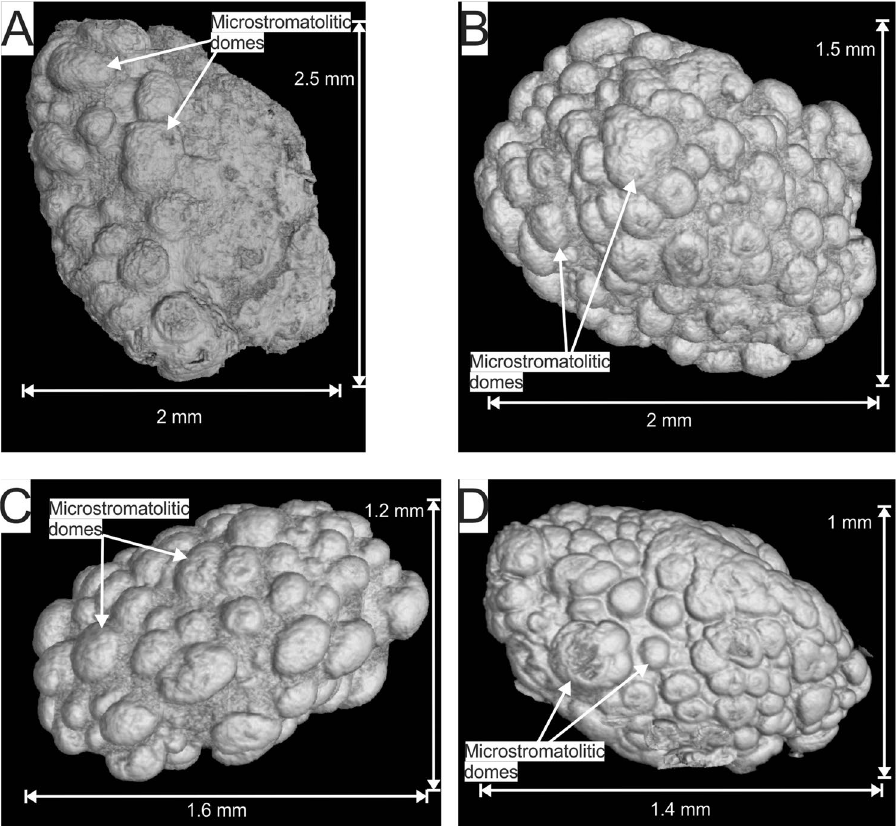
Figure 3. False colour three dimensional reconstructions of µ XCT scans of the same four magnetite coated granules from Fig. 2 from drill core samples of the Nconga Formation GIF illustrating the multiple domical structures surrounding, or coating, the outer surface of all the granules. See the following supplementary videos for full rotational animations of the extracted granules: 6 for granule A; 8 for granule B; 10 for granule C; 11 for granule D. The images were created using VGStudio Max version 3.2 (https://www.volumegraphics.com/en/ products/vgstudio-max.html) and the final figure was compiled in CorelDRAW 2017